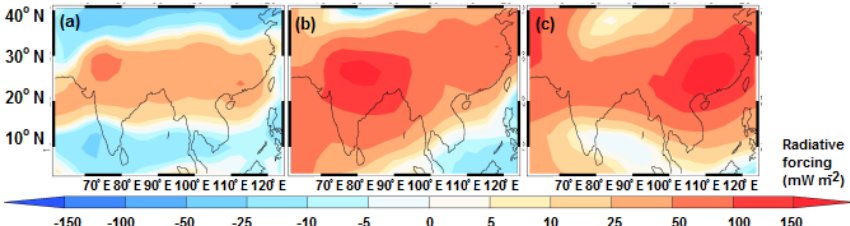
Figure 6. Latitude–longitude distribution of changes in ozone radiative forcing (in mWm − 2 ) for the (a) Ind38, (b) Ind73, and (c) Chin73 perturbed simulations, compared to the CTRL